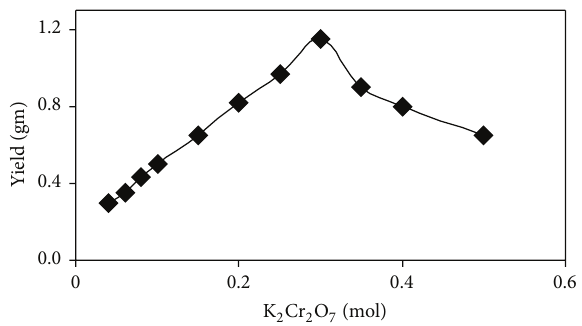
Figure 3: Yield-monomer concentration effect on the aqueous oxidative polymerization of poly-o-phenylenediamine (POPDA).